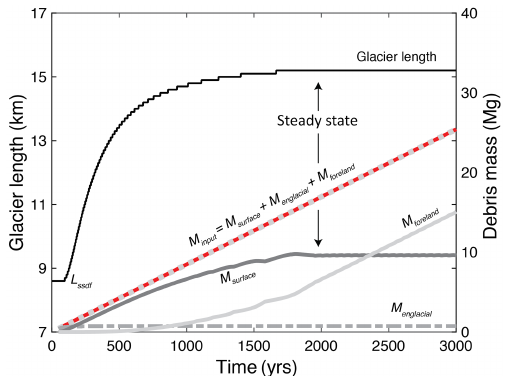
Figure 4. Debris mass vs. time. The englacial debris mass reaches steady state rapidly because debris is deposited near the ELA and englacial advection paths are short. As debris emerges in the abla- tion zone M surface increases nearly at the rate of debris input to the glacier. As the glacier nears a steady length the debris mass trans- ferred to the glacier foreland increases. The glacier reaches steady state when ˙ d flux = ˙ d term and the glacier length is steady (see Ap- flux pendix A).